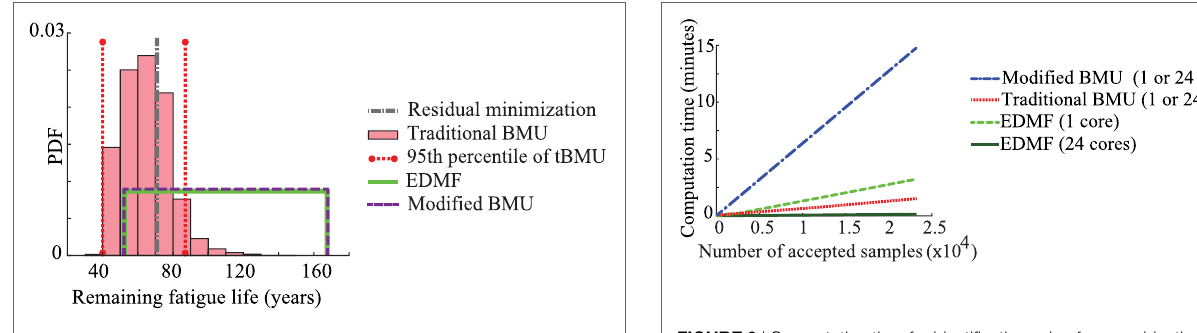
loading scenario.